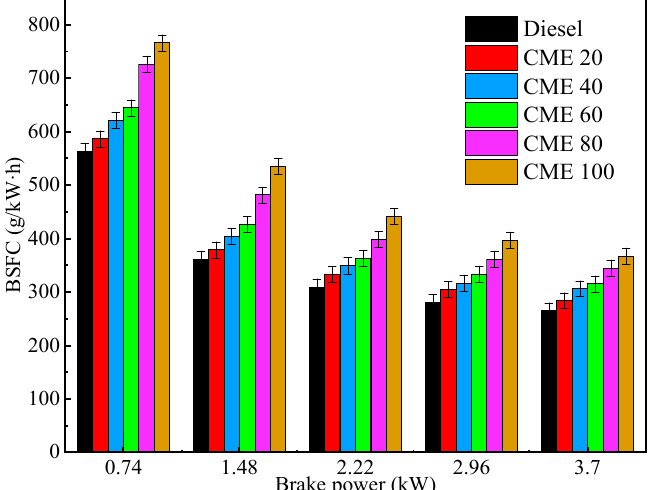
Figure 18. BSFC comparison of CME blends and diesel under different brake powers [185].